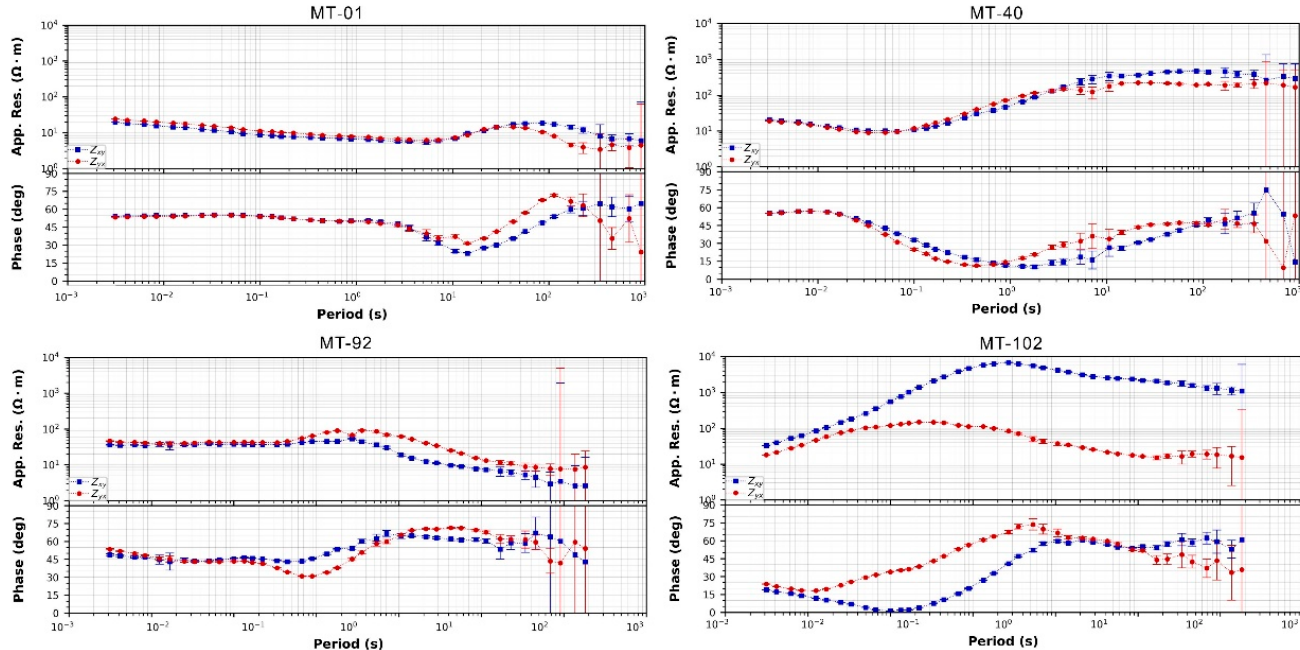
Figure 2. The apparent resistivity-phase curves of MT stations from different parts of the study area.